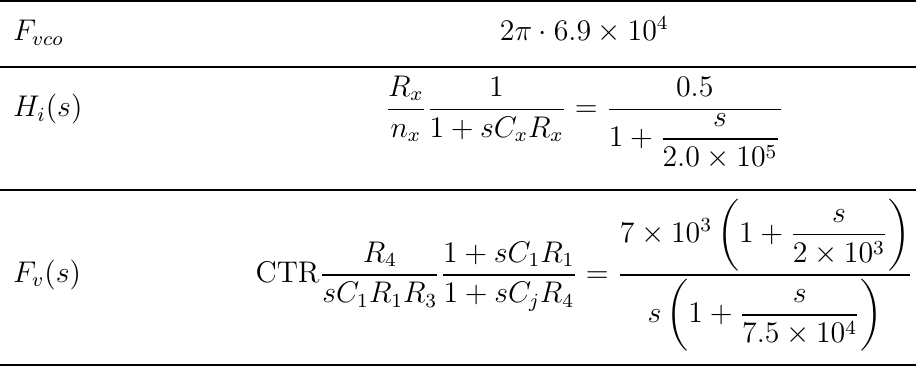
Figure 2. Functional block diagram of current-mode controlled LLC converter. F ( s ) is the transfer function of the current voltage controlled oscillator (VCO) gain and H i ( s ) is the feedback compensation of the voltage feedback circuit. feedback circuit, and F v Table 1. Expressions for Gain Blocks in Figure